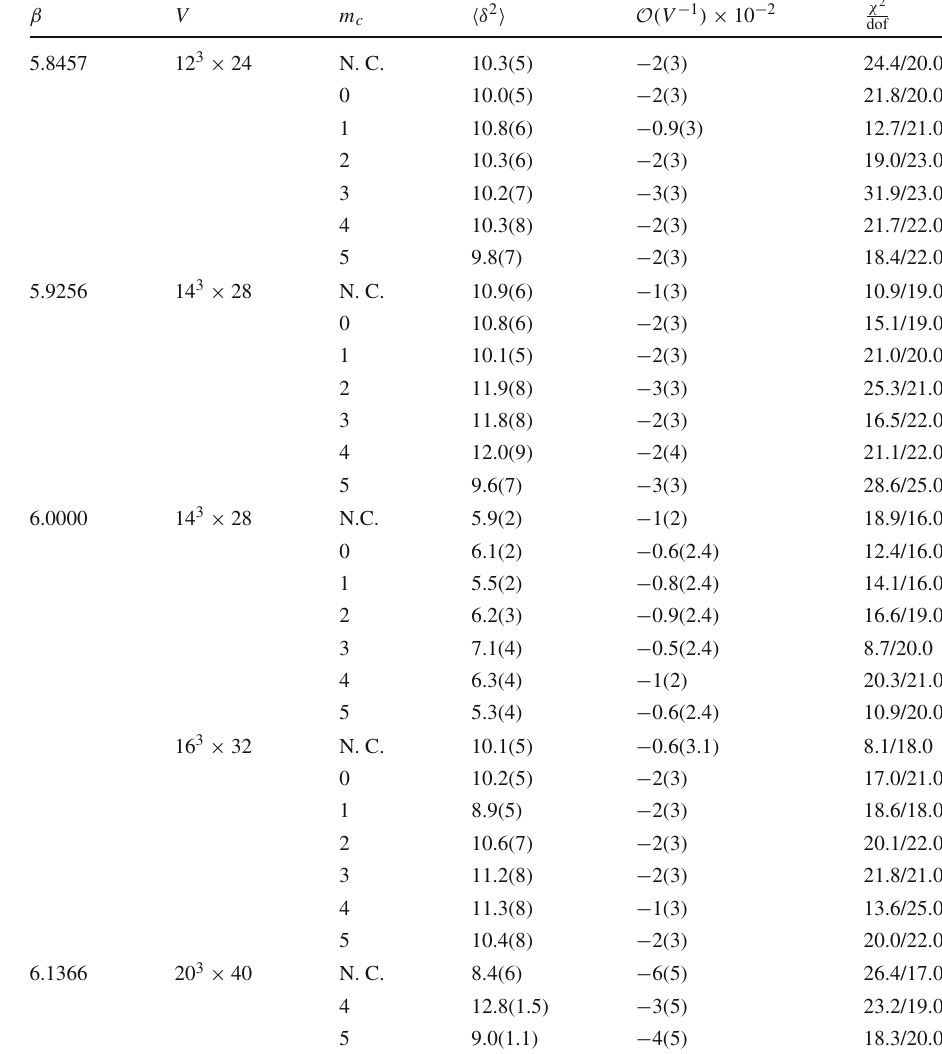
Table 8 The fitting results of the distributions of the topological charges by the prediction functions. The fitting range FR is − 17 ≤ Q ≤ 17 .